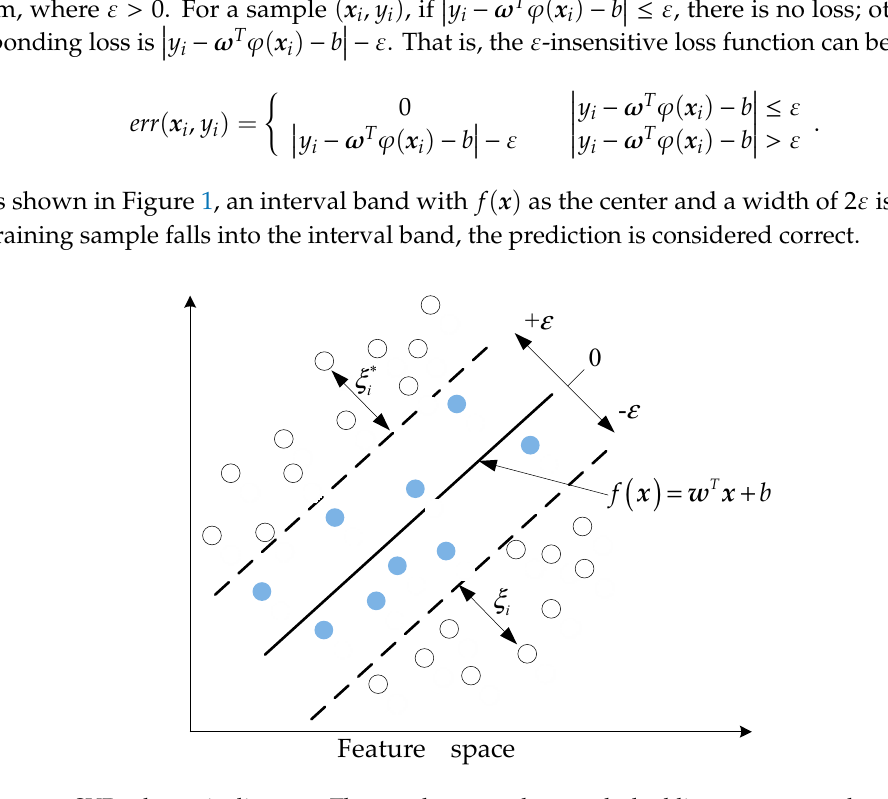
Figure 1. SVR schematic diagram. The area between the two dashed lines represents the ε -interval band; the predicted loss of samples falling into this area is not calculated.